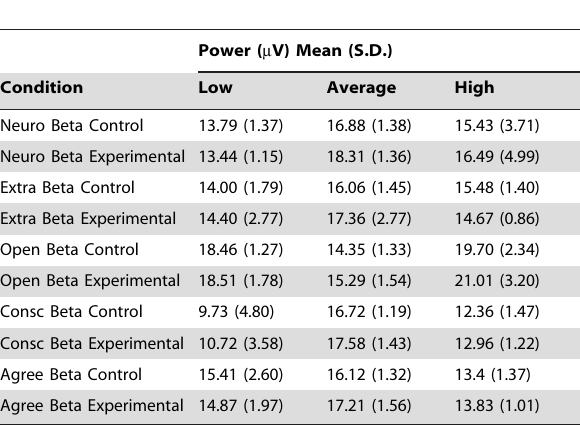
Table 5. Beta Cortical Power Spectral Density by Personality Trait, Trait Score and